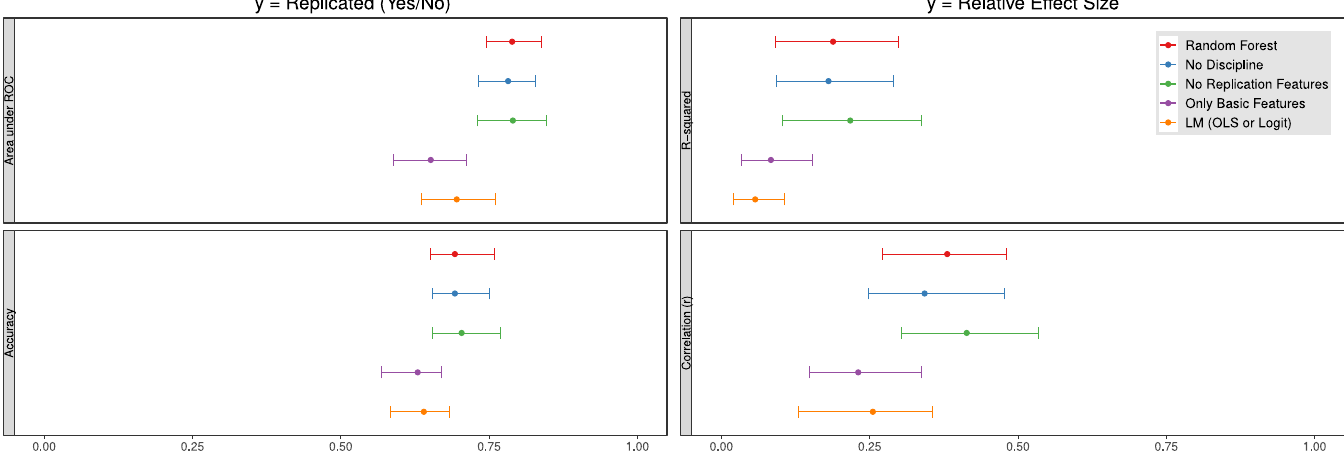
Fig 3. Interquartile range (IQR) and median of Random Forest classifier (left) and regression (right) validation set performance. For the classifier, the optimal model (first from top) has an average AUC of 0.79 and accuracy of 70% at the 50% probability cutoff (accuracy is mainly driven by a high true negative rate; unsuccessful replications are predicted with an accuracy of 80%, while successful only with 56%). The optimal regression model has a median R 2 of 0.19 and a Spearman ρ of 0.38. The second bar from the top in each subplot shows unchanged model performance when dummy indicators for discipline (Economics, Social or Cognitive Psychology) are removed. The third has excluded any features unique to the replication effort (e.g. replication team seniority) with no observable loss of performance. The less accurate fourth model is only based on original effect size and p-value. Last, the model at the bottom is a linear model trained on the full feature set, for reference. See S3 Fig for more